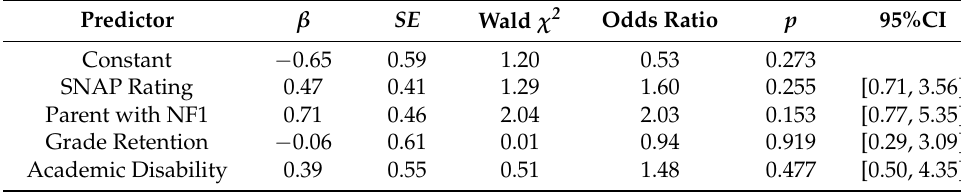
Table 5. Logistic regression analysis of child report of bully victimization.